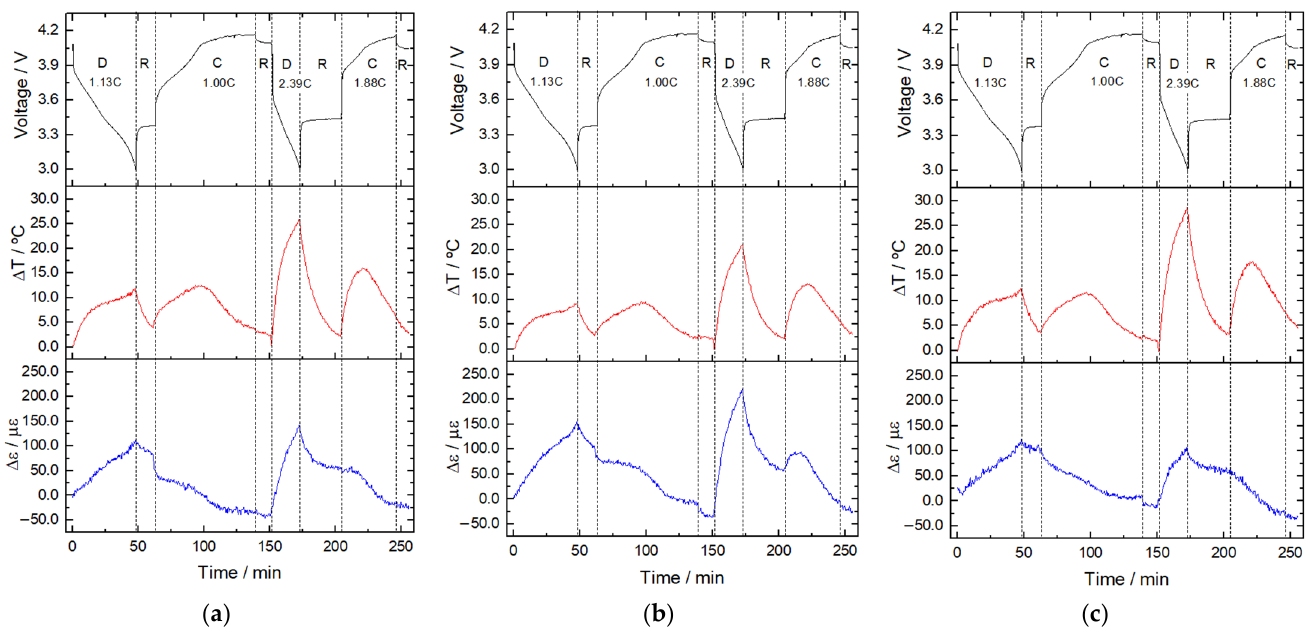
Figure 6. ( a ) Temperature and strain variations detected over voltage performance for ( a ) negative terminal (PM ‐ FBG 1), ( b ) middle (PM ‐ FBG 2), and ( c ) positive terminal (PM ‐ FBG 3) of the battery.